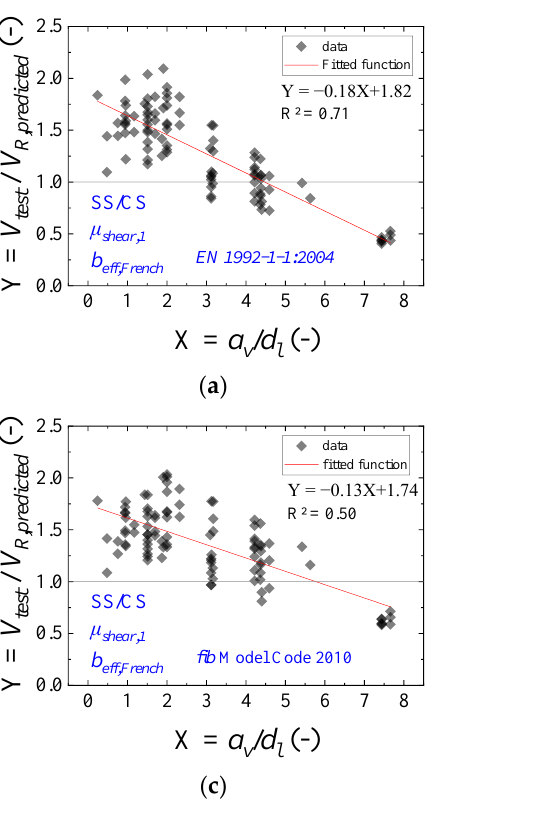
Figure 13. Calibration of μ shear,2 for ( a ) simply supported and continuous slabs using the current Eu- rocode expressions; ( b ) cantilever slabs using the current Eurocode expressions; ( c ) simply supported and continuous slabs using the fib Model Code 2010 expressions; ( d ) cantilever slabs using the fib Model Code 2010 expressions. Note: SS = simple support (hinged support); CS = continuous support; CT = cantilever slab.